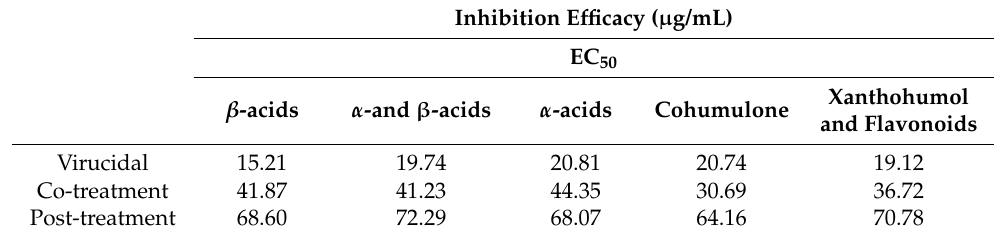
Table 2. Inhibition efficacy (EC 50 ) of hops compounds in Vero cell lineages.